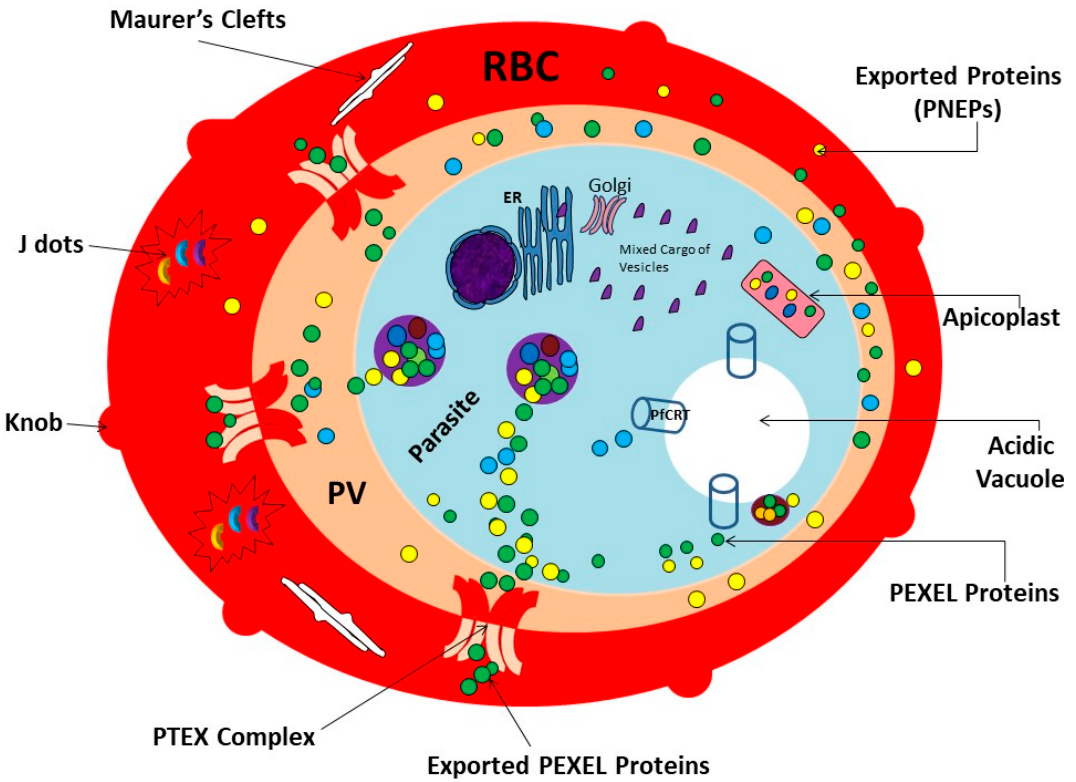
Figure 1. P. falciparum protein export pathways . ER—endoplasmic reticulum; PV—parasitophorous vacuole; PTEX— Plasmodium translocon of exported proteins; RBC—red blood cell; PEXEL—proteins export element; PNEPs—PEXEL-negative export proteins; PfCRT— Plasmodium falciparum chloroquine transporter. The figure was adapted from [11,14,15].